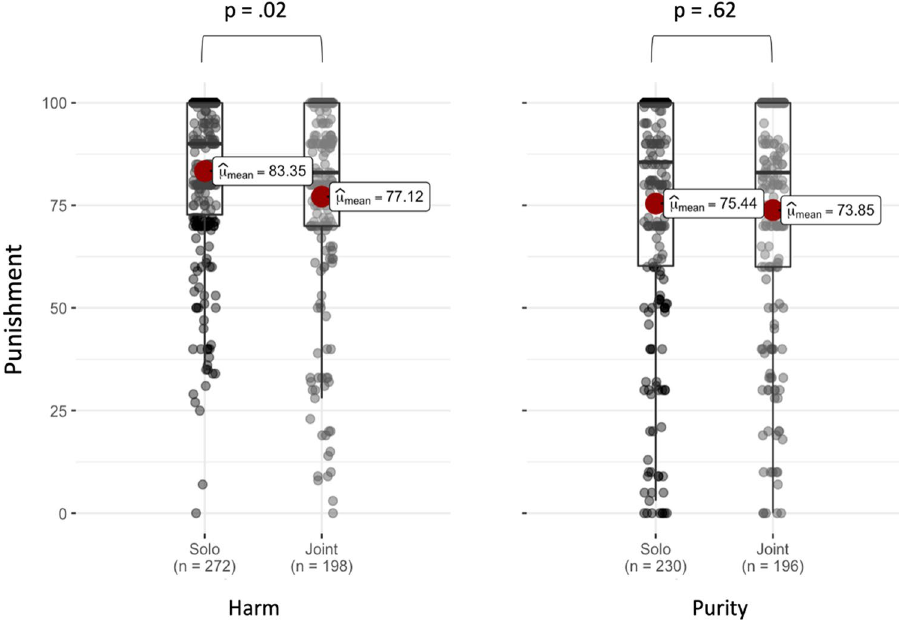
Figure 3. Harmfulness (left) and Grossness (right) ratings are matched across Joint and Solo actions but significantly different across Domains: Harmfulness is higher in Harm (left), and grossness is higher in Purity (right) scenarios. Graph conventions are the same as Fig.